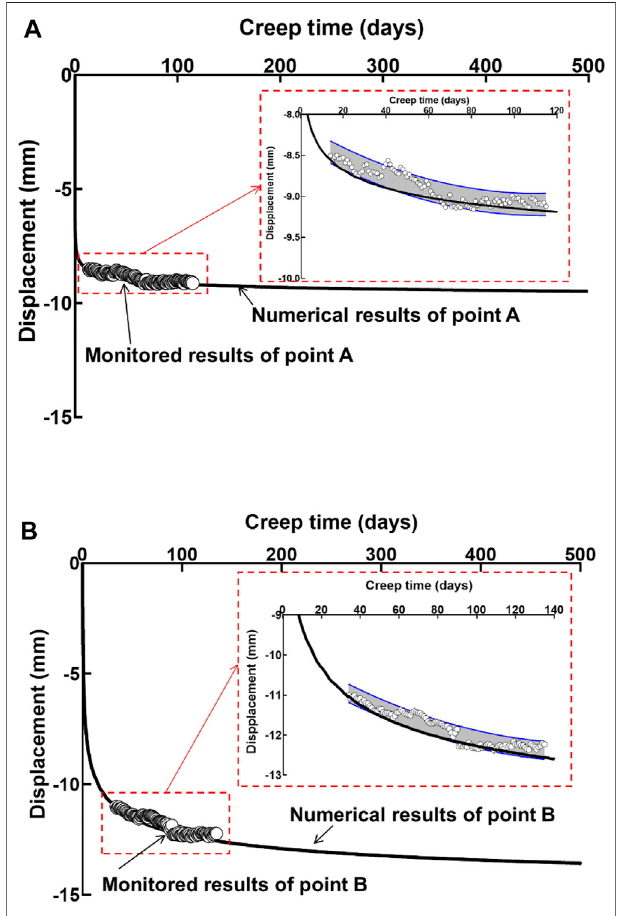
FIGURE 9 | Comparison between numerical results and monitored results for (A) point A and (B) point (A).